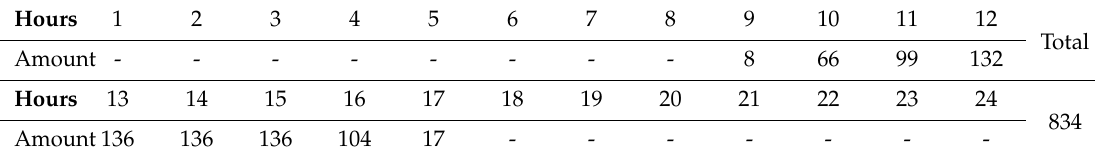
Figure 2. Comparison of power from reliability must-run (RMR) units, high-voltage direct currents (HVDCs), renewable sources, and total demand. Table 2. Required curtailment in Jeju power system